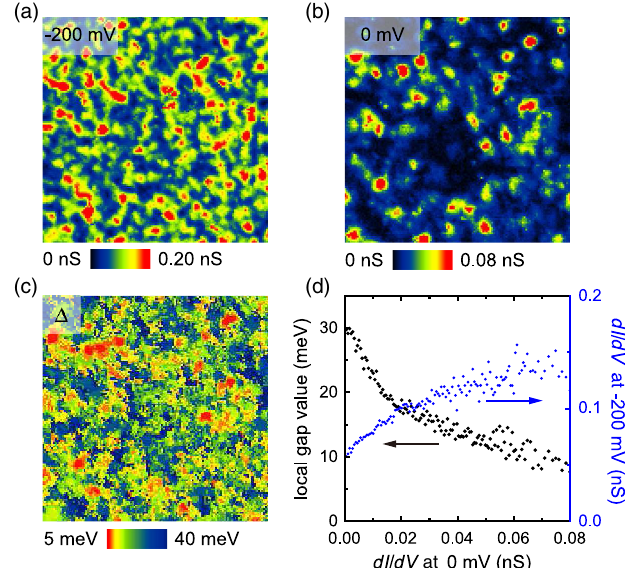
FIG. 6. (a),(b) dI=dV image over the same field of view as in Fig. 5(a) with bias voltages of − 200 and 0 mV. (c) Spatial distribution of the size of the V-shaped gap shown in Fig. 5(c). (d) Cross-correlation plot of the − 200 mV peak height versus the local insulating gap magnitude (black) and residue DOS at E F (blue), revealing negative and positive correlations,